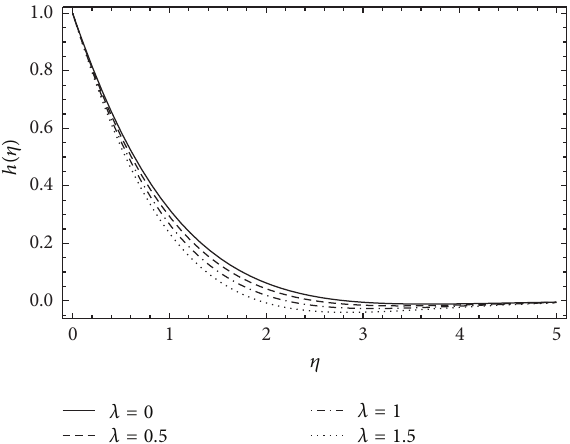
Figure 8: The influence of the rotation parameter 𝛼 on 𝑘(𝜂) for 𝜆 = 1 , ℏ = −0.1 .